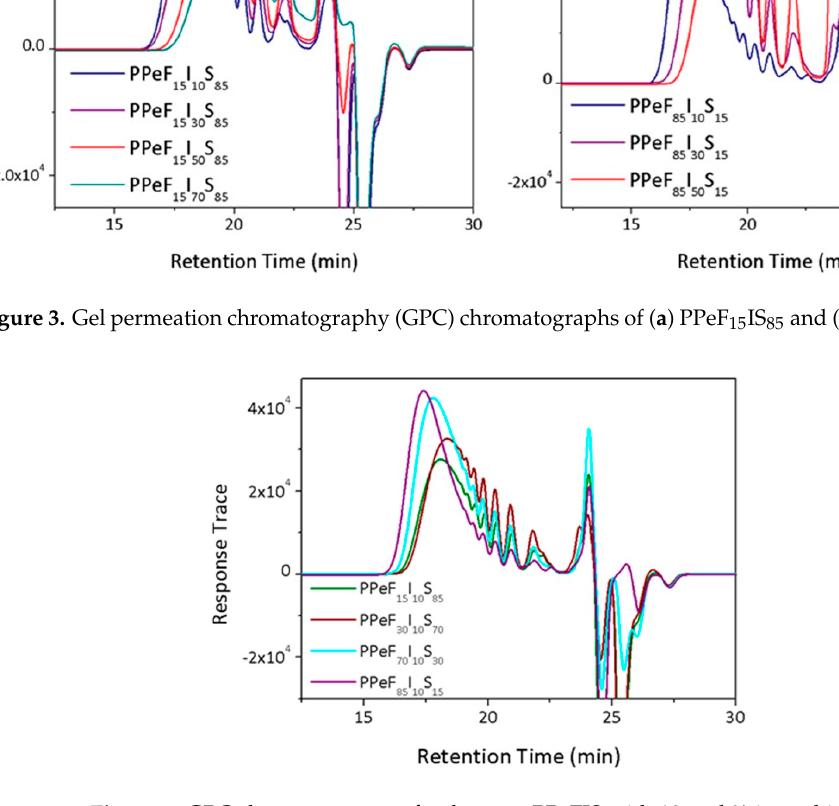
Figure 4. GPC chromatograms of polyesters PPeFIS with 10 mol %